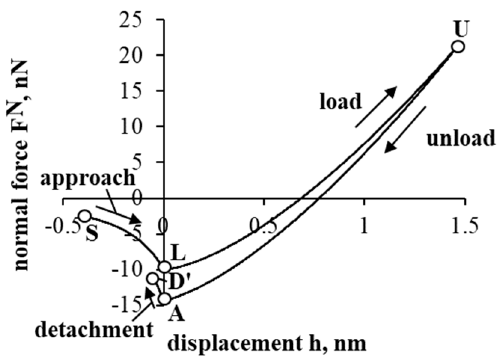
Figure 2. Normal force versus displacement. Model of adhesive-dissipative interaction of a particle.